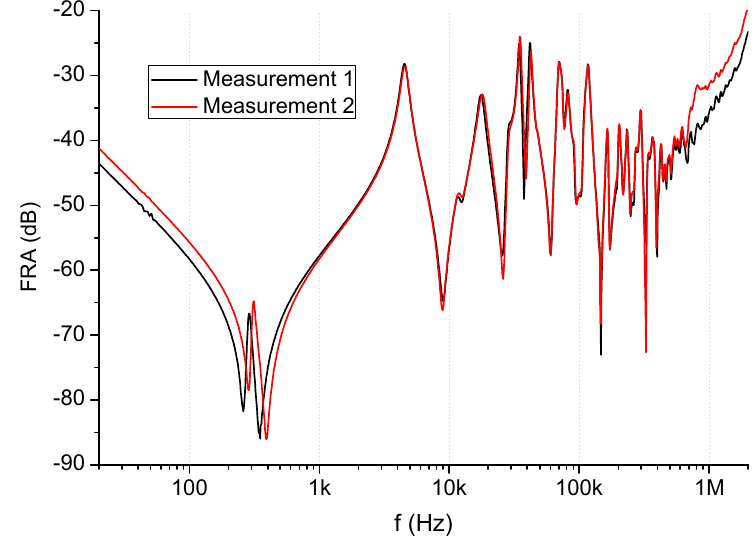
Figure 13. FR of distribution transformer with different core magnetization.